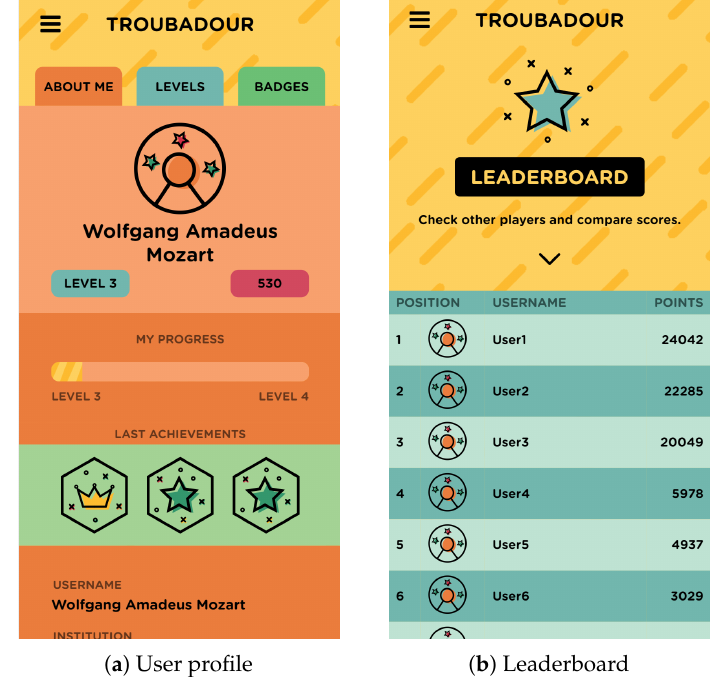
Figure 5. The user profile and the leaderboard screens. The user can set their avatar and change their profile information ( left ). The user can observe the collected points of other players on the leaderboard screen ( right